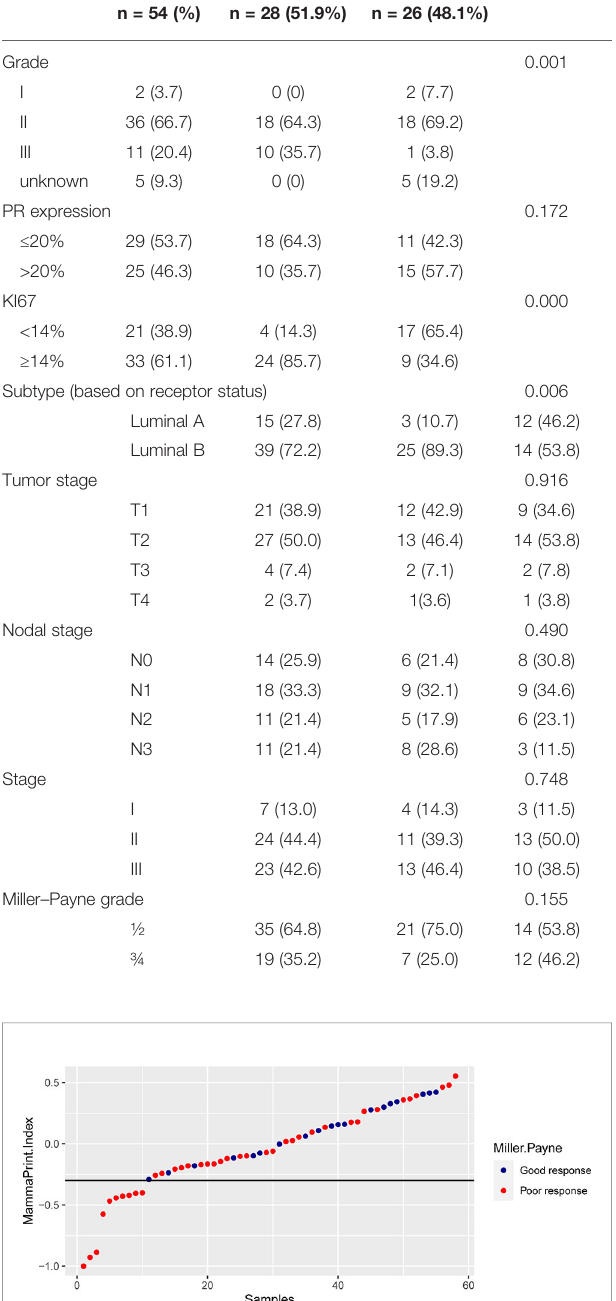
FIGURE 2 | The association between the classi fi cation of the 70-gene recurrence risk and the pathological response.